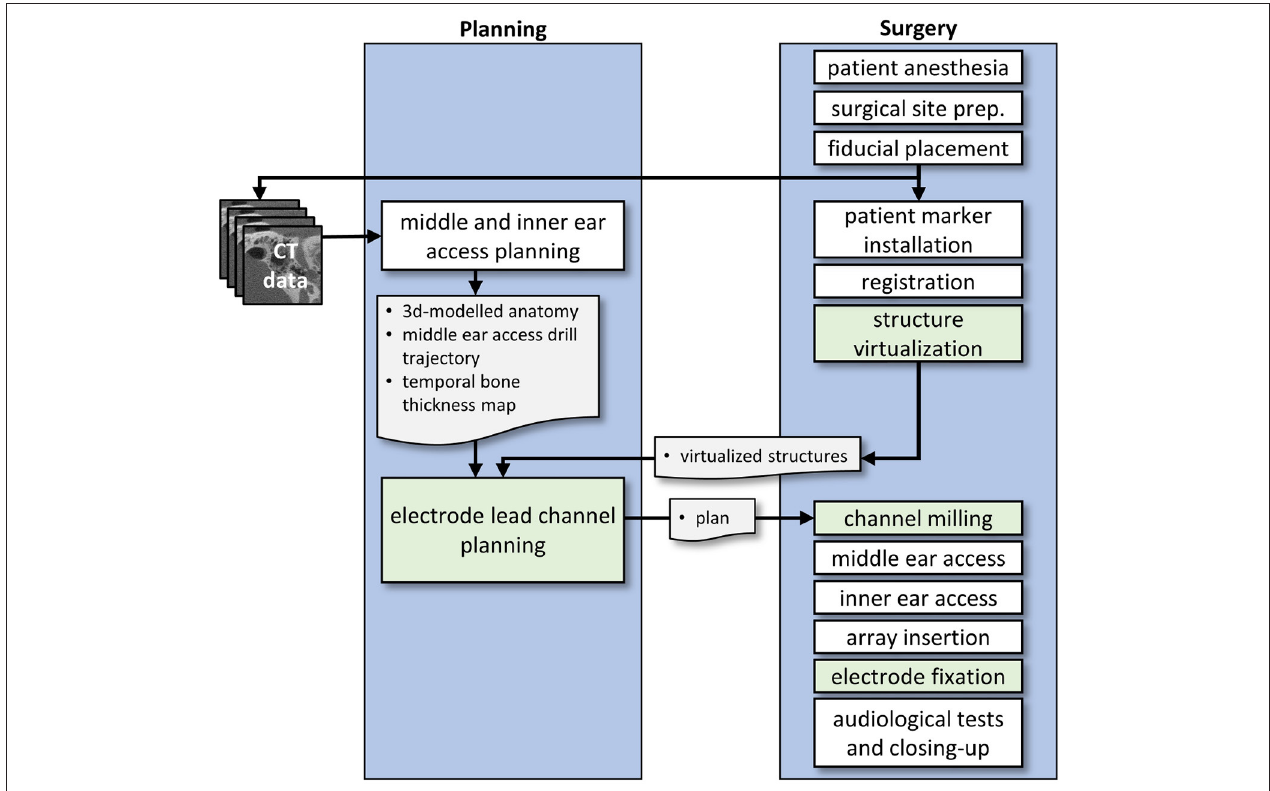
FIGURE 2 | Conceptual workflow of the proposed electrode lead management technique. During middle ear and inner ear access planning, there is a possible concurrency when the structure virtualization can be completed. The results of both processes are required for electrode lead channel planning. Workflow elements that are developed and investigated in this work are marked in green